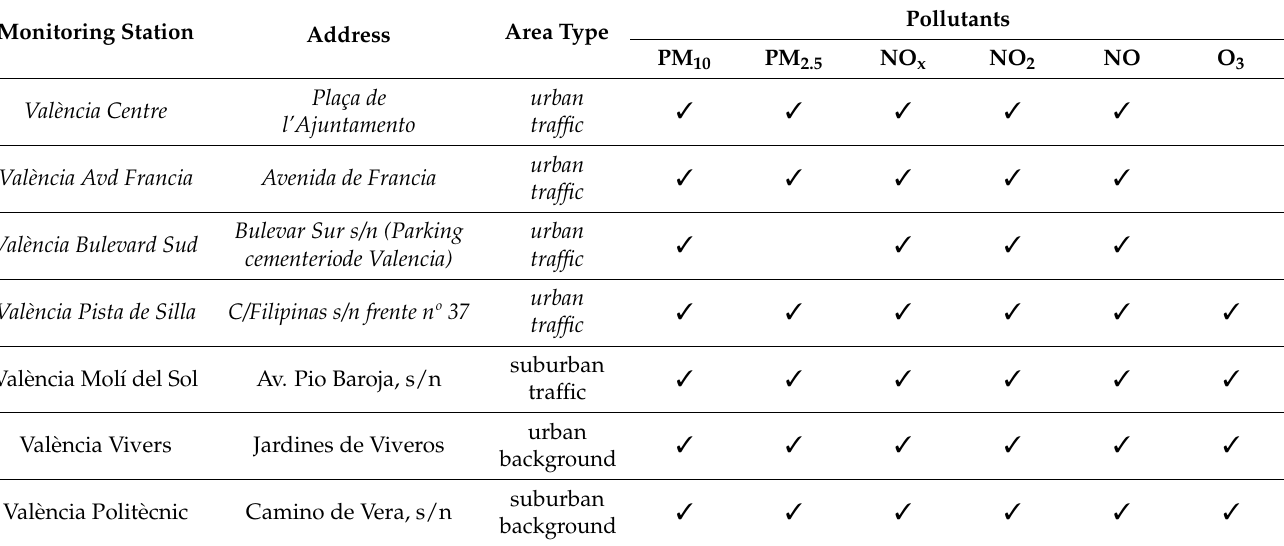
Table 1. Characteristics of the air monitoring stations included in the present